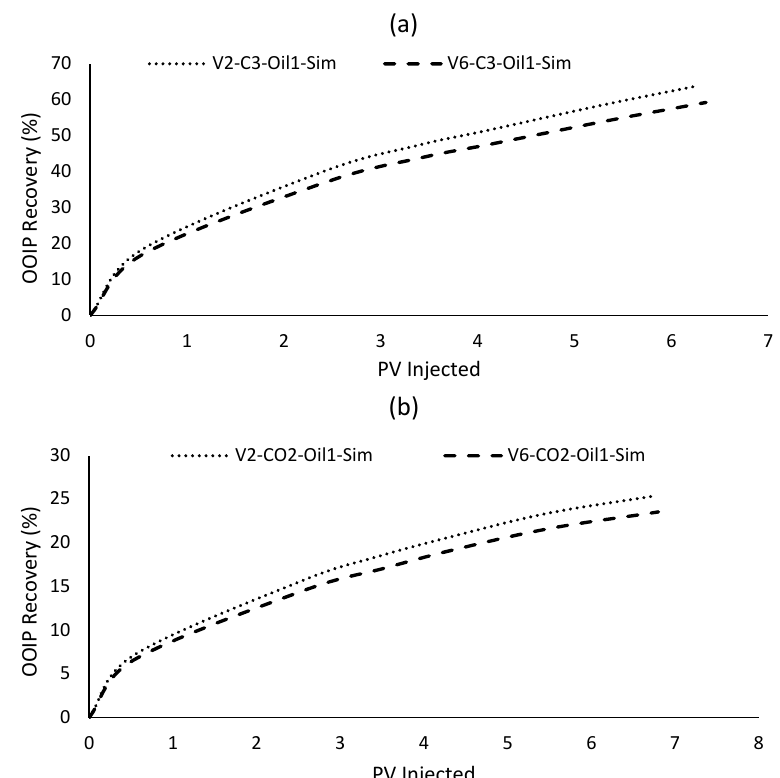
Figure 12. The effect of fracture length on the recovery factors in conventional VAPEX and patterns V1 and V5 using propane ( a ) and carbon dioxide ( b ).